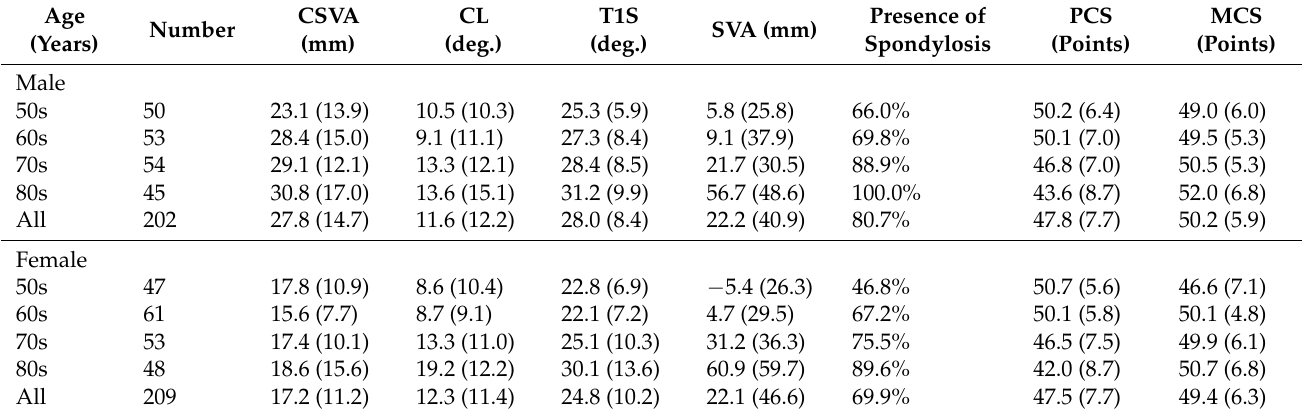
Table 2. Tabulation results of spine parameters and SF8 TM summary scores.